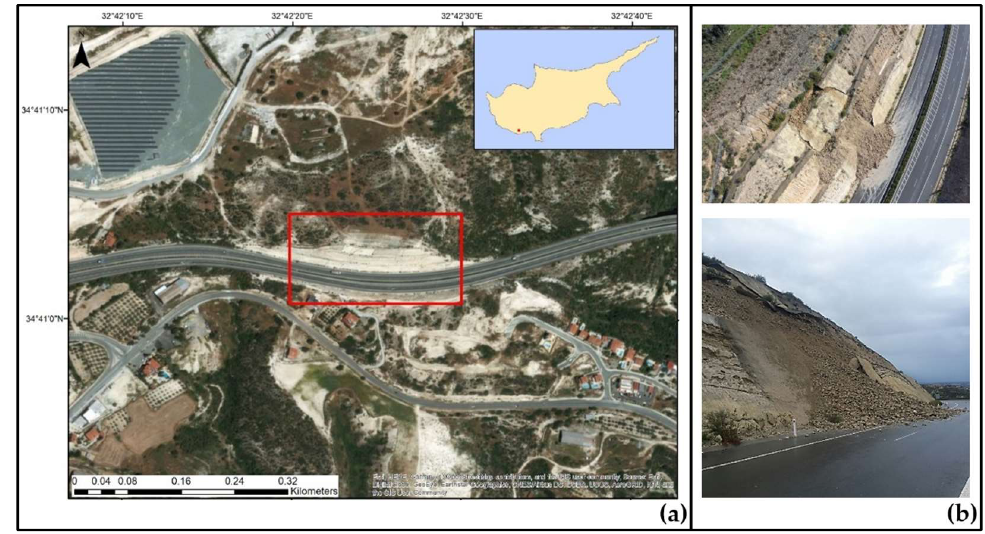
Figure 1. ( a ) The case study area by the A6 motorway near Pissouri where a landslide occurred on 15 February 2019. The wider area affected by the landslide is marked by a red rectangle [29]. ( b ) Photos from the landslide scene showing the impact of the landslide, provided by the Cyprus Geological Survey Department [29].